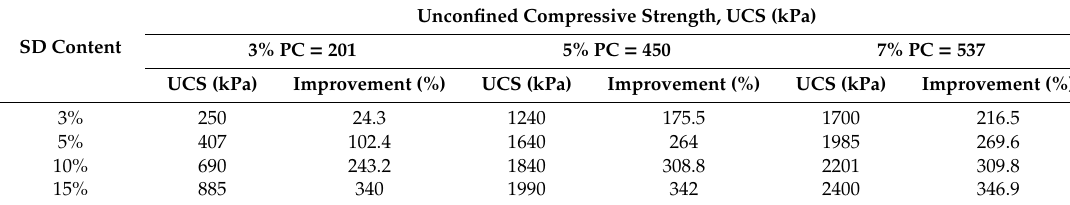
Table 11. UCS results after sulphate exposure in presence of SD (90 days